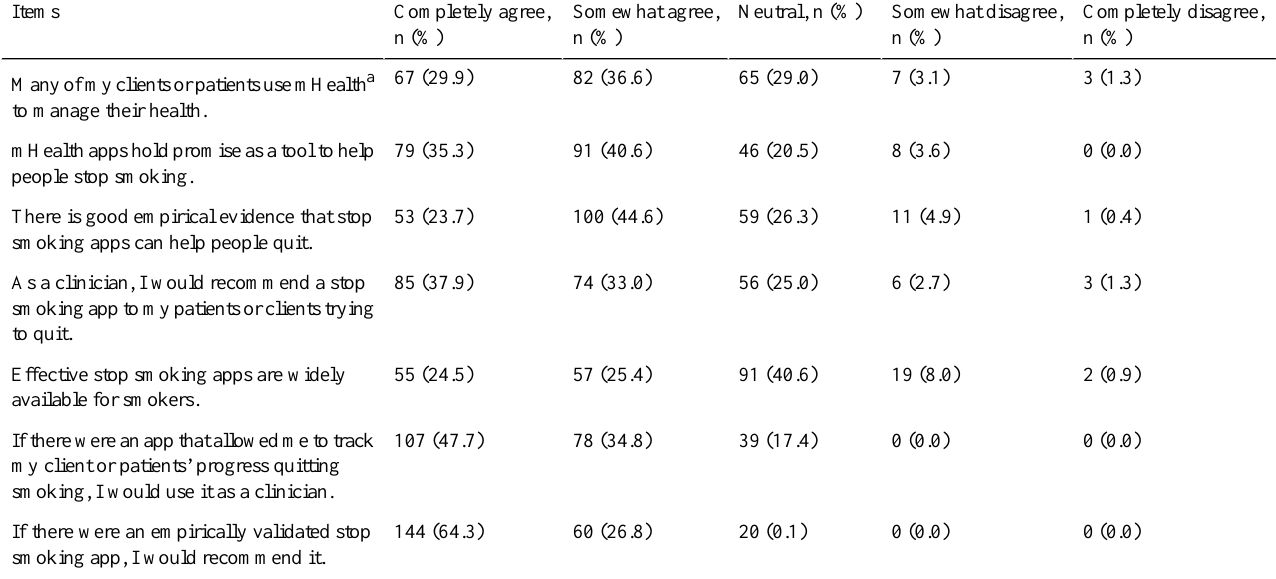
Table 3. Providers’attitudes and beliefs about smoking cessation apps.